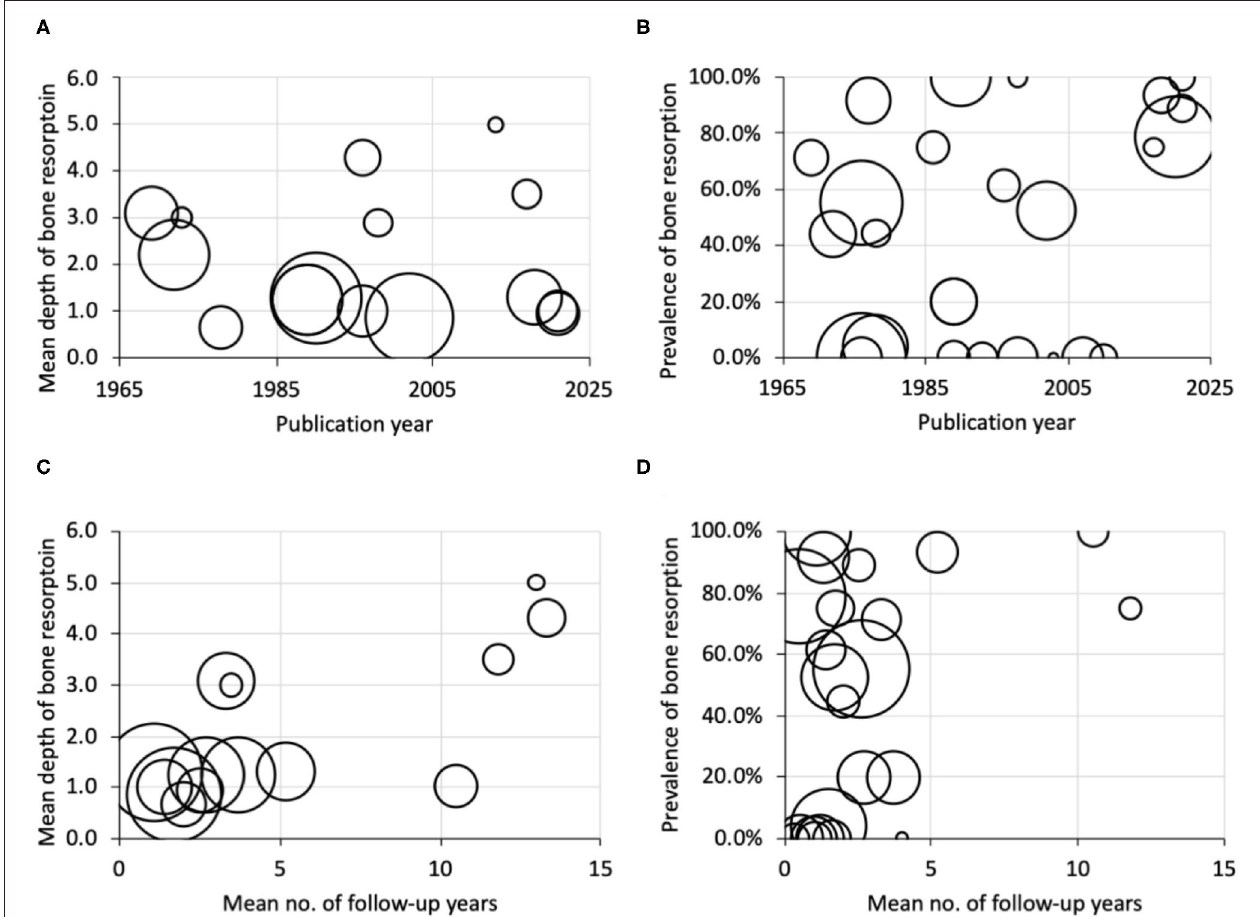
FIGURE 3 | Bubble plots of publication year against (A) mean depth of bone resorption, (B) prevalence of bone resorption, and of the mean number of follow-up years against, (C) mean depth of bone resorption, and (D) prevalence of bone resorption. Bubble size indicates the sample size.